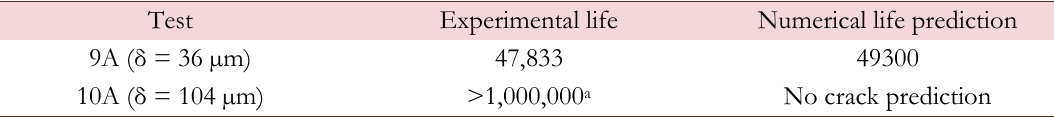
Table 1: Comparison between experimental life and numerical